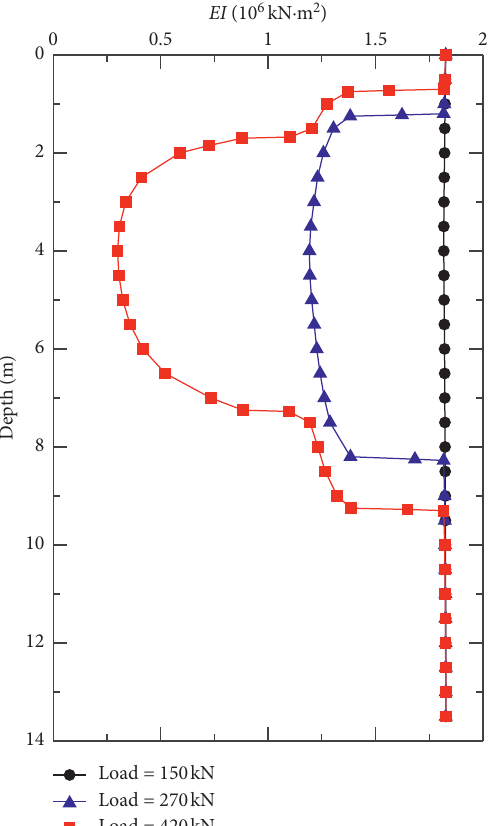
Figure 9: Flexural rigidity of the pile at different loads.